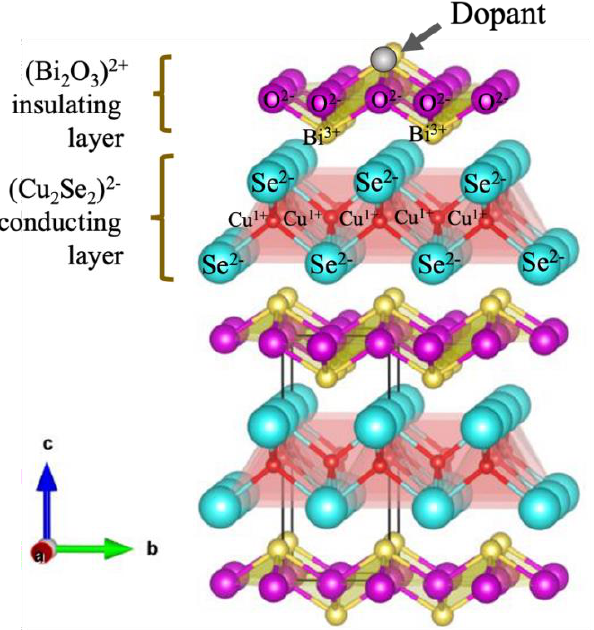
Figure 1. The crystal structure of BiCuSeO consists of conducting (Cu 2 Se 2 ) 2 − layer and insulating (Bi 2 O 3 ) 2+ layer. It also shows the dopant substituted at the Bi site. (Bi 2 O 3 ) 2+ layer. It also shows the dopant substituted at the Bi